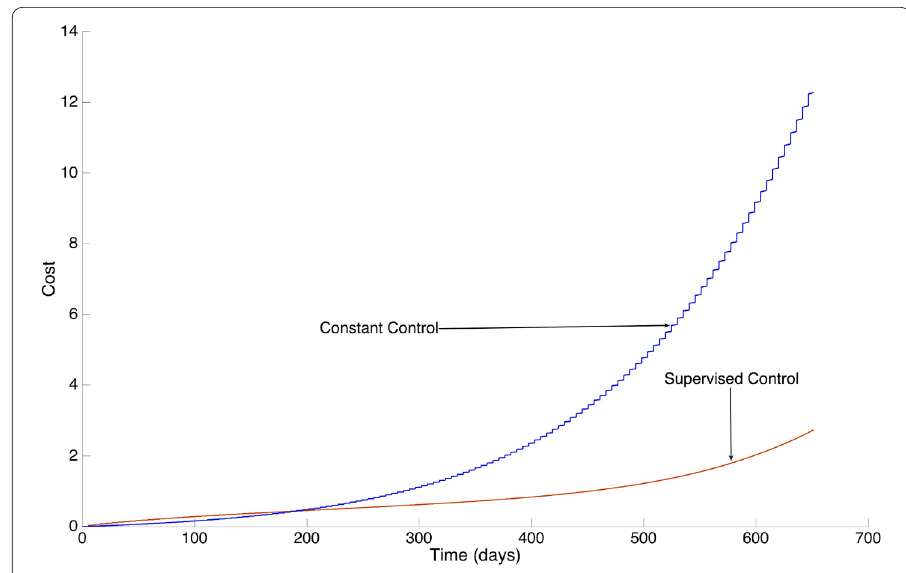
Figure 6 A comparison between supervised control and a constant control strategies